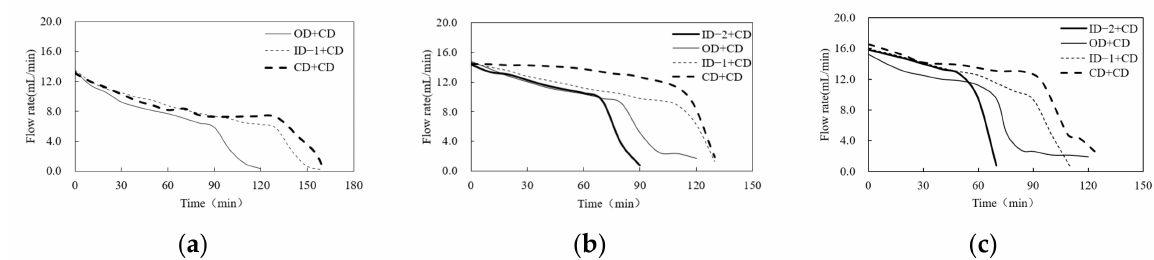
Figure 6. Conventional subsurface-drainage flow-rate variation under different combined drainage forms; ( a ) Shallow – shallow combination; ( b ) Medium – medium combination; ( c ) Deep – deep combination.